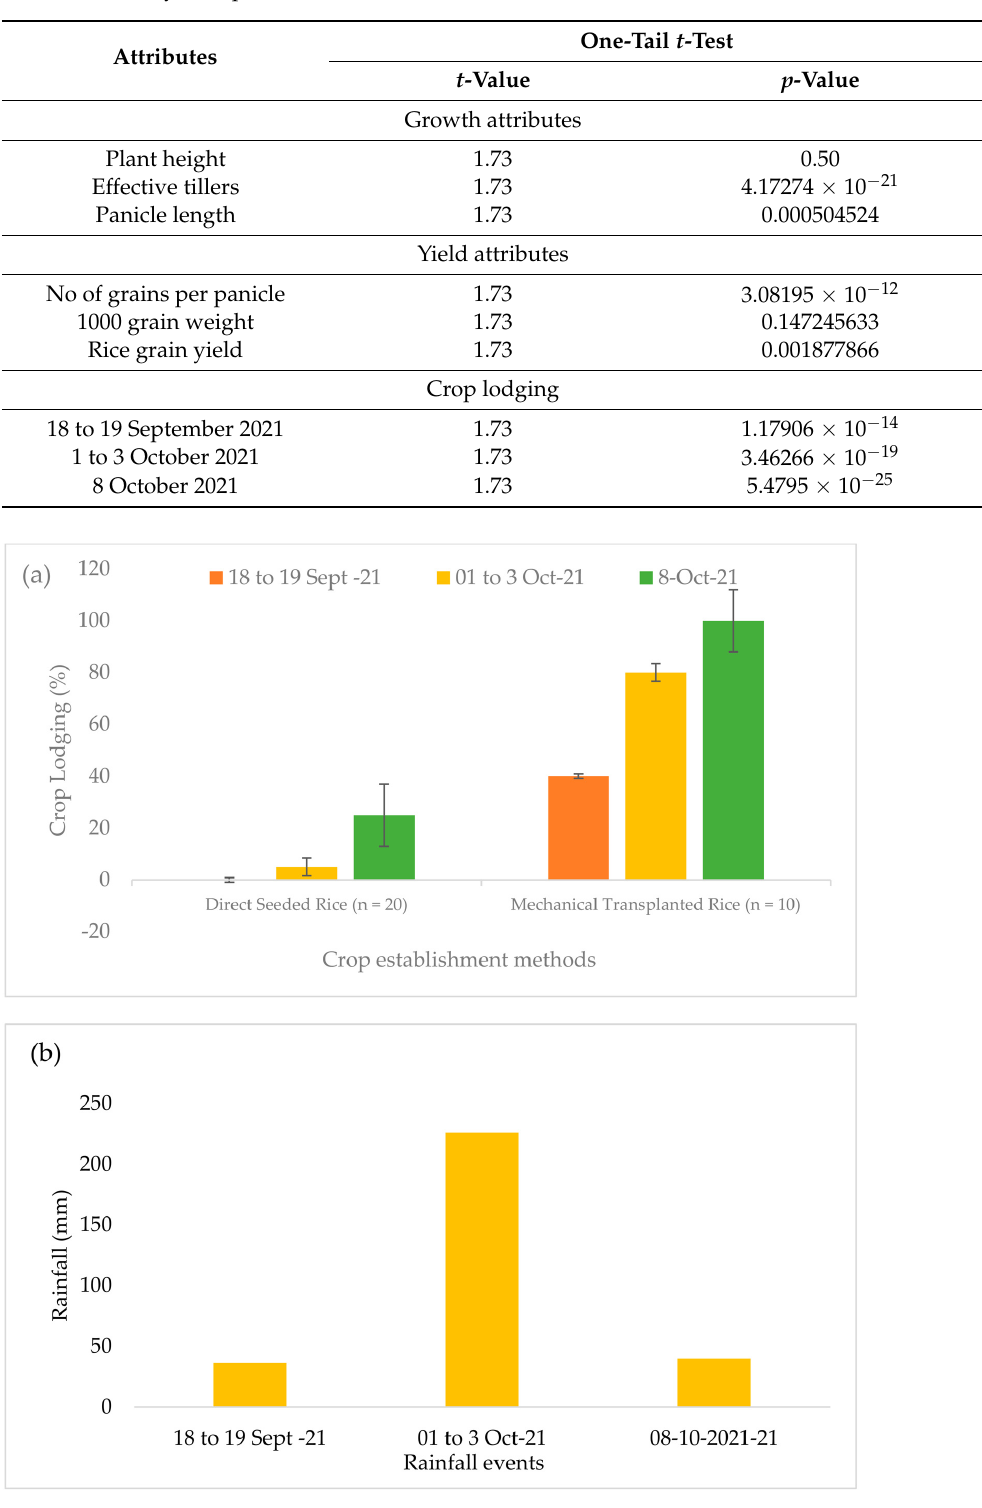
Figure 7. ( a ) Effect of crop establishment methods on crop lodging percentage. Vertical bars for each column indicate standard deviation of the mean (for direct seeded rice n = 20 and in mechanically transplanted rice n = 10) and ( b ) Cumulative rainfall events during the experimental